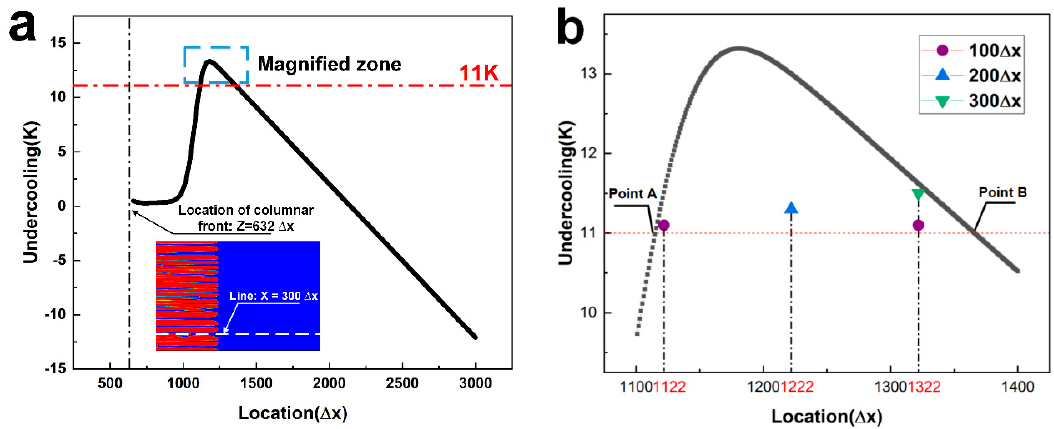
Figure 11. ( a ) The undercooling distribution along the line y = 300 ∆ x at the 7.0 × 10 5 ∆ t ; ( b ) The undercooling distribution in magnified zone.